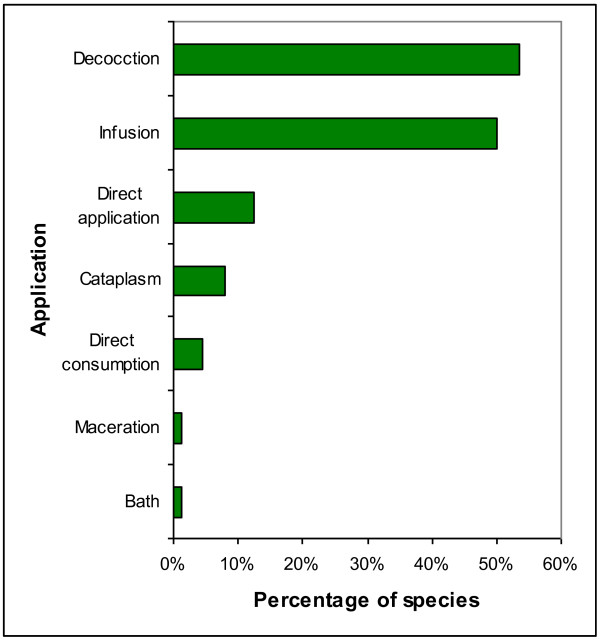
Mode of application.